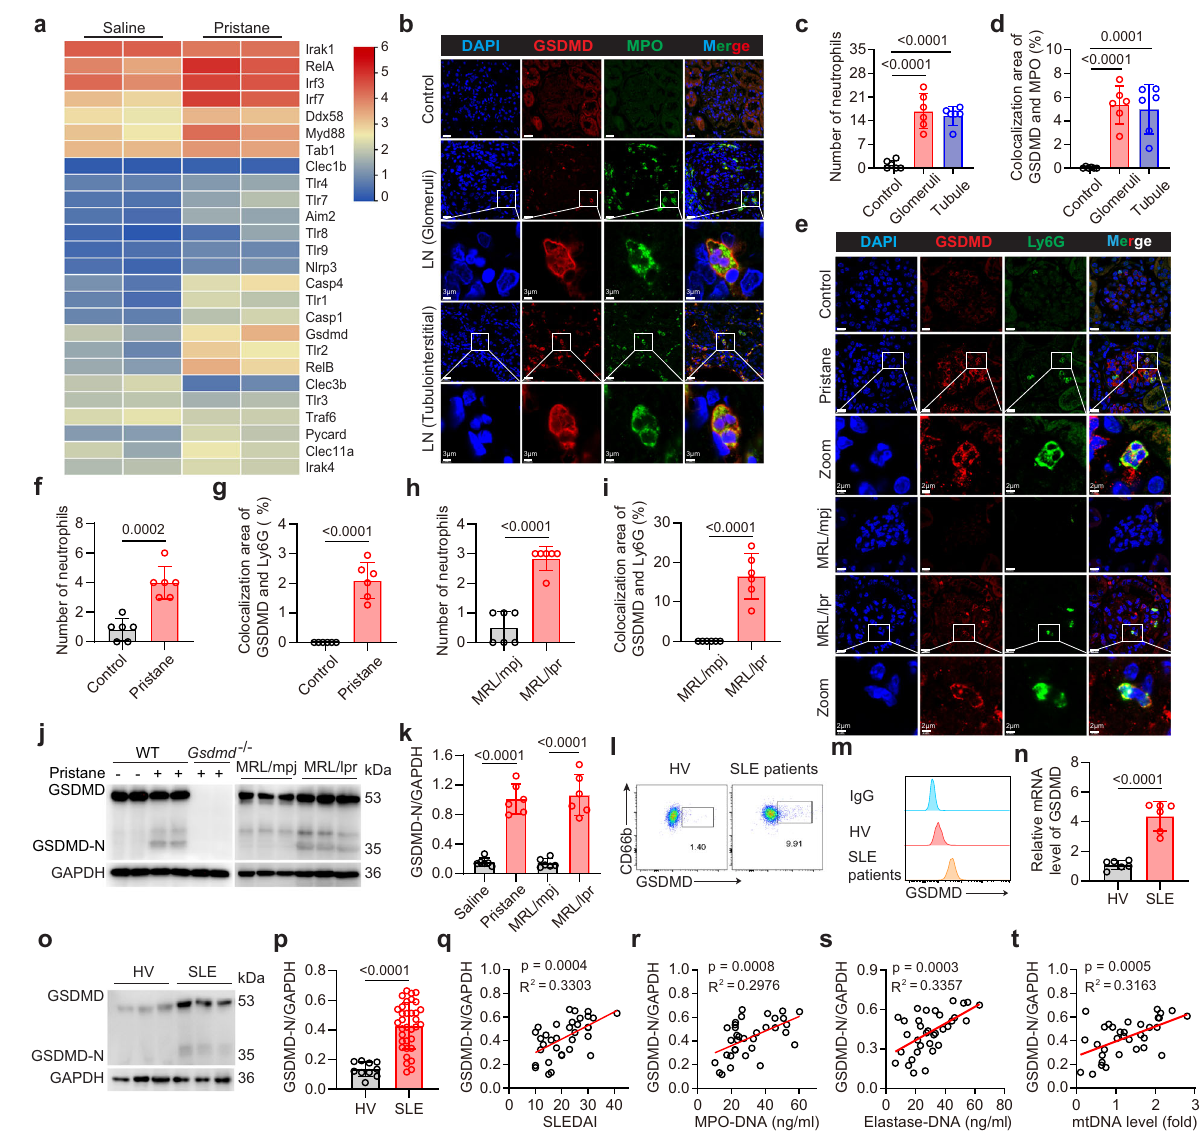
Fig. 1 | GSDMD is activated in neutrophils from lupus mice and SLE patients. a Heatmap of genes involved in DAMP sensing pathways that are differentially expressed between the kidneys of mice treated with saline and pristane. b Immuno fl uorescence staining for GSDMD and MPO in glomeruli and tubu- lointerstitial of renalbiopsy from lupus nephritis (LN) patients. Scale bar, 20 μ m, 3 μ m(enlarged). c , d Quantitativeanalysisofnumbersofneutrophilsper fi eldofview (FOV) or co-localization area of GSDMD and MPO in FOV. Tumor-adjacent normal tissue samples of 3 renal carcinoma patients or renal biopsies from 3 LN patients. Theresultsarepooledfromtwoindependentexperiments. e Immuno fl uorescence staining for GSDMD and Ly6G in kidney from PIL and MRL/lpr mice. Scale bar, 10 μ m. 2 μ m (enlarged). f – i Numbersof neutrophilsor co-localization areaof GSDMD and Ly6G per FOV. n =6 mice. j Immunoblotting ofGSDMD and GSDMD-N in bone marrow (BM) neutrophils from wide-type (WT), PIL, pristane-treated Gsdmd − / − , MRL/mpj and MRL/lpr mice. k Quantitative analysis of GSDMD-N/GAPDH. n =6 mice. The samples shown are from the same experiment. Three blots (PIL group)